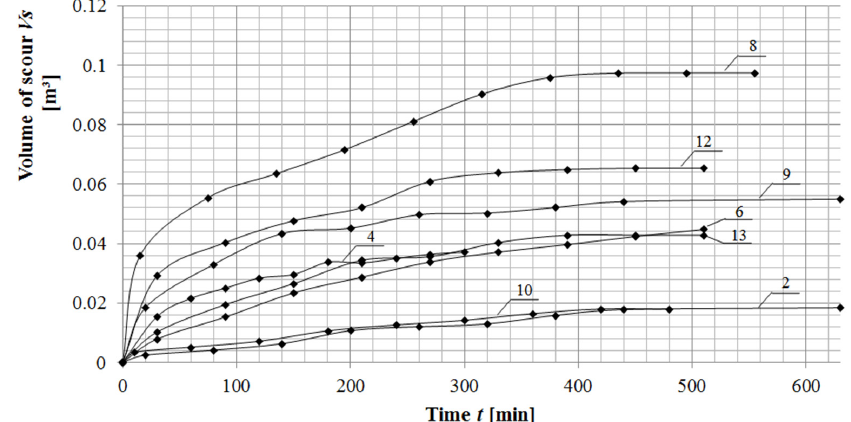
Figure 7. Amount of bedload scattered from the dissipation basin (sandy bed) in variants with visible scour during test runs No 2, 6, 8, 9, 10, 12; Where 1–13 are the numbers of the measurements (compare with Tables 1 and 2).